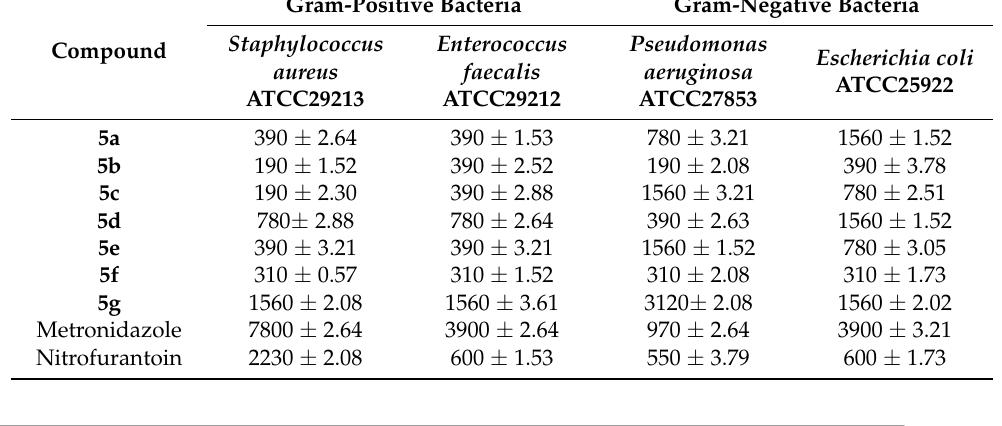
Table 4. Minimum biofilm inhibition concentration (MBIC) for synthesized compounds.